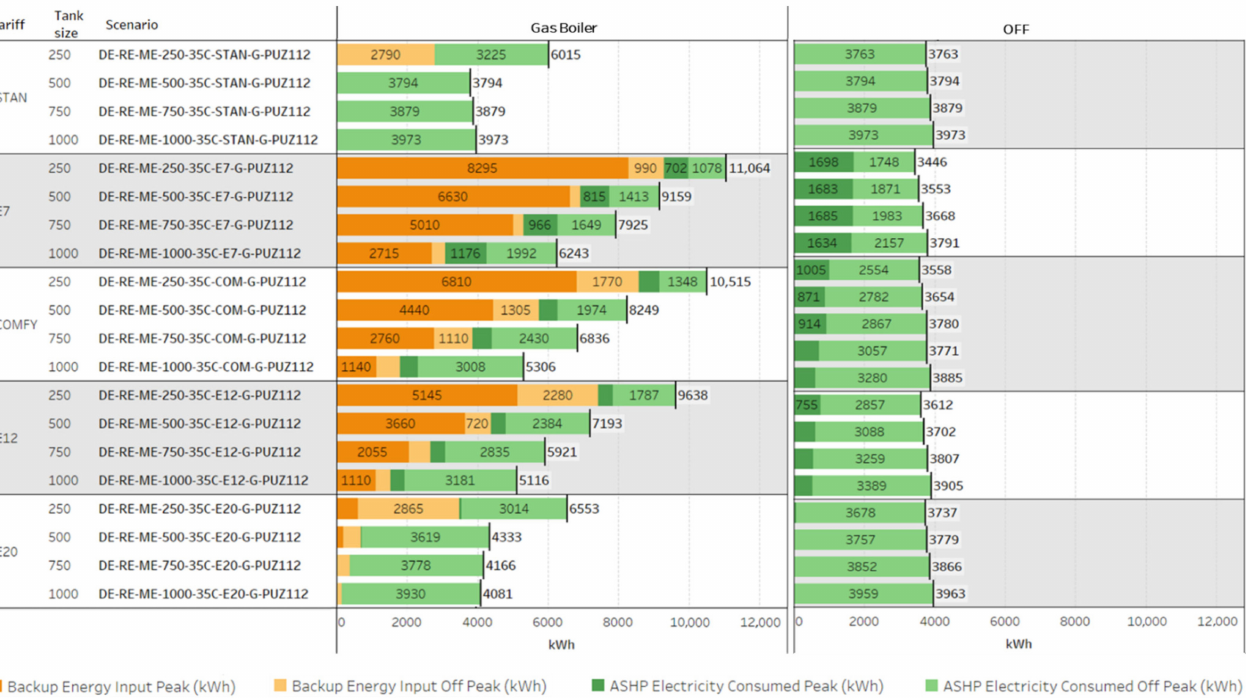
Figure 6. Energy input of backup scenario analysis for heat pump and backup heater during off-peak and peak